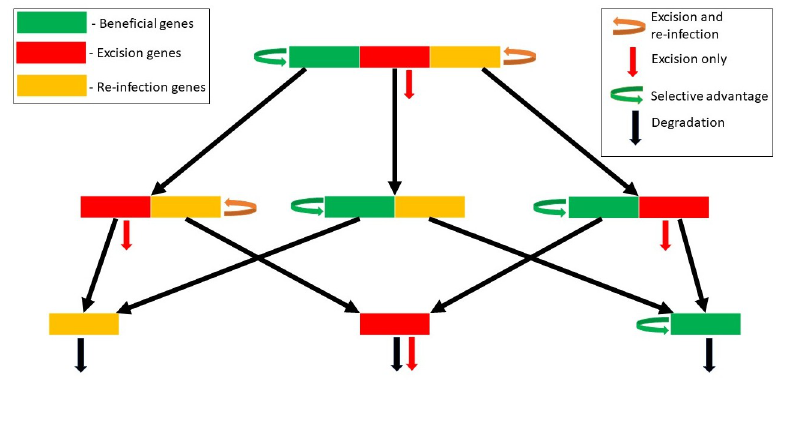
Fig 2. Schematic diagram of the mathematical